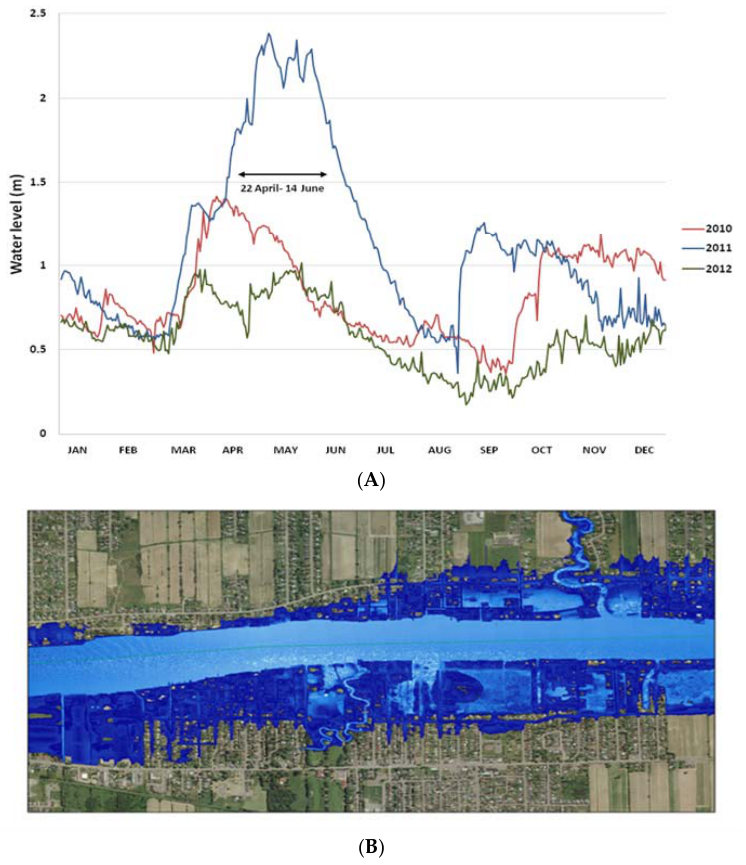
Figure 2. Geographic Information System (GIS) approach: defining the study areas. ( A ) Water levels of the Richelieu River in 2011 compared to 2010 and 2012; ( B ) Identification of the areas affected by the flood using the ArcGIS software.